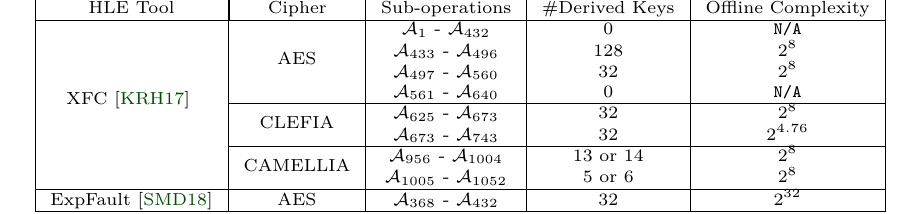
Table 5: Output of HLE Tools. XFC was used to evaluate ciphers for Differential Fault Attacks, ExpFault was used to evaluate AES for Impossible Differential Fault Attacks.